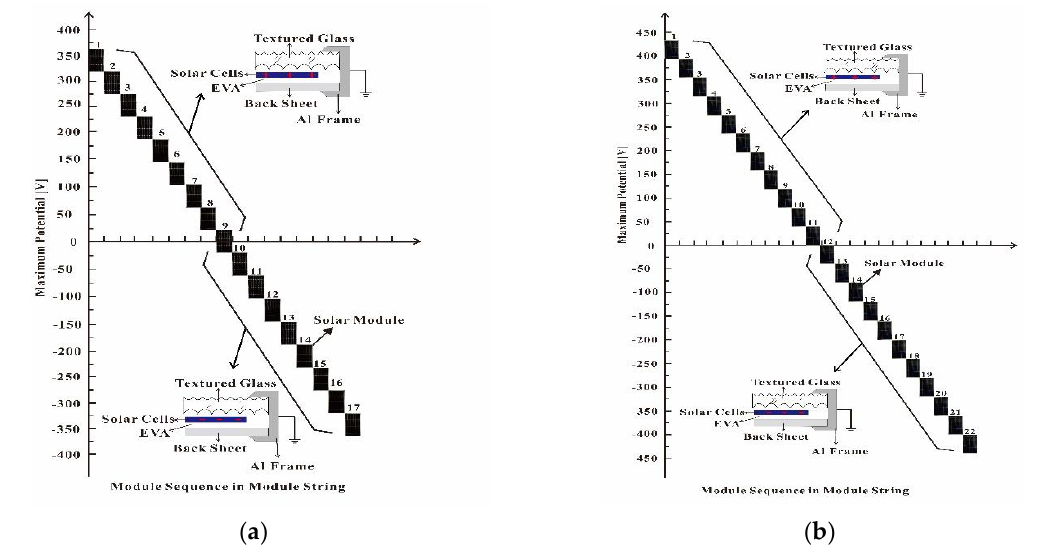
Figure 4. The potential distribution of solar modules between solar cellandaluminium frame in two types module string. ( a ) Module string made up of 17 solar modules with 72 pieces solar cells in series; ( b ) Module string made up of 22 solar modules with 60 pieces solar cells in series.